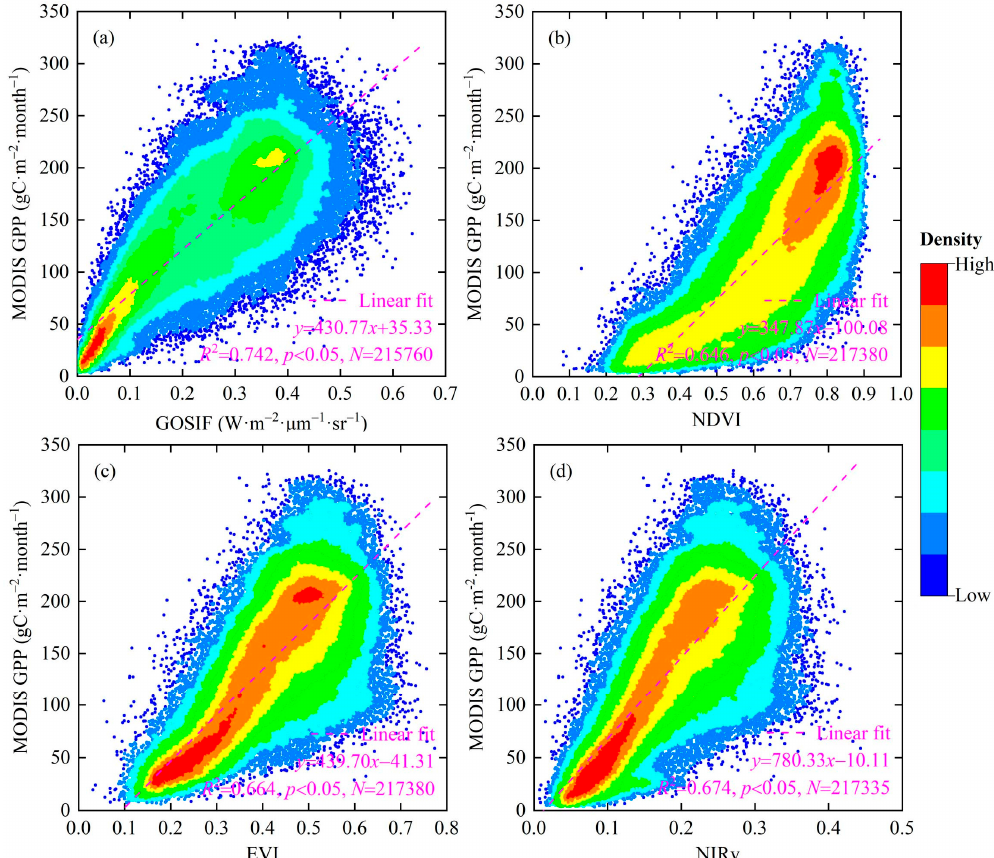
Figure 13. Scatter fitting between MODIS GPP and GOSIF ( a ), NDVI ( b ), EVI ( c ), and NIRv ( d ) during July–December 2019. Note: Each dot denotes the monthly value for each pixel (0.05° × 0.05°); N indicates the data size. Table 2. Spatial consistency between standardized anomalies of MODIS GPP and that of SIF, NDVI, EVI, and NIRv during July–December in 2019.